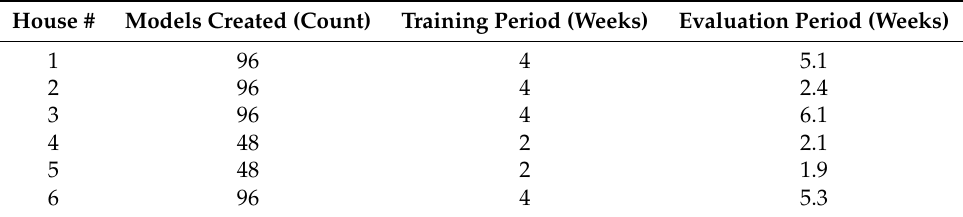
Table 3. Summary of model training and evaluation for each house.